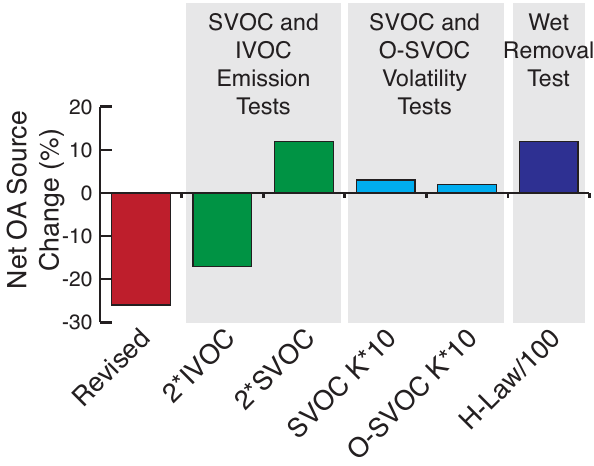
Fig. 10. Change in global OA net source (from all types of organic aerosol) for sensitvitiy tests. Values are relative to traditional simu- lation at 4 ◦ × 5 ◦ using GISS meteorology. Sensitivity tests are given in Table 6.